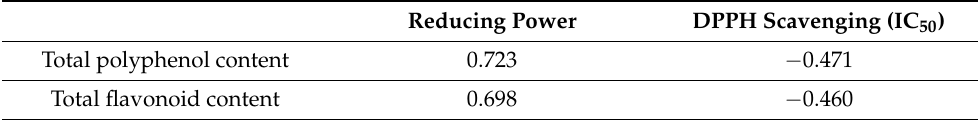
Table 2. Correlation coefficients among total polyphenols, total flavonoids, and antioxidant activities of the eggplant .